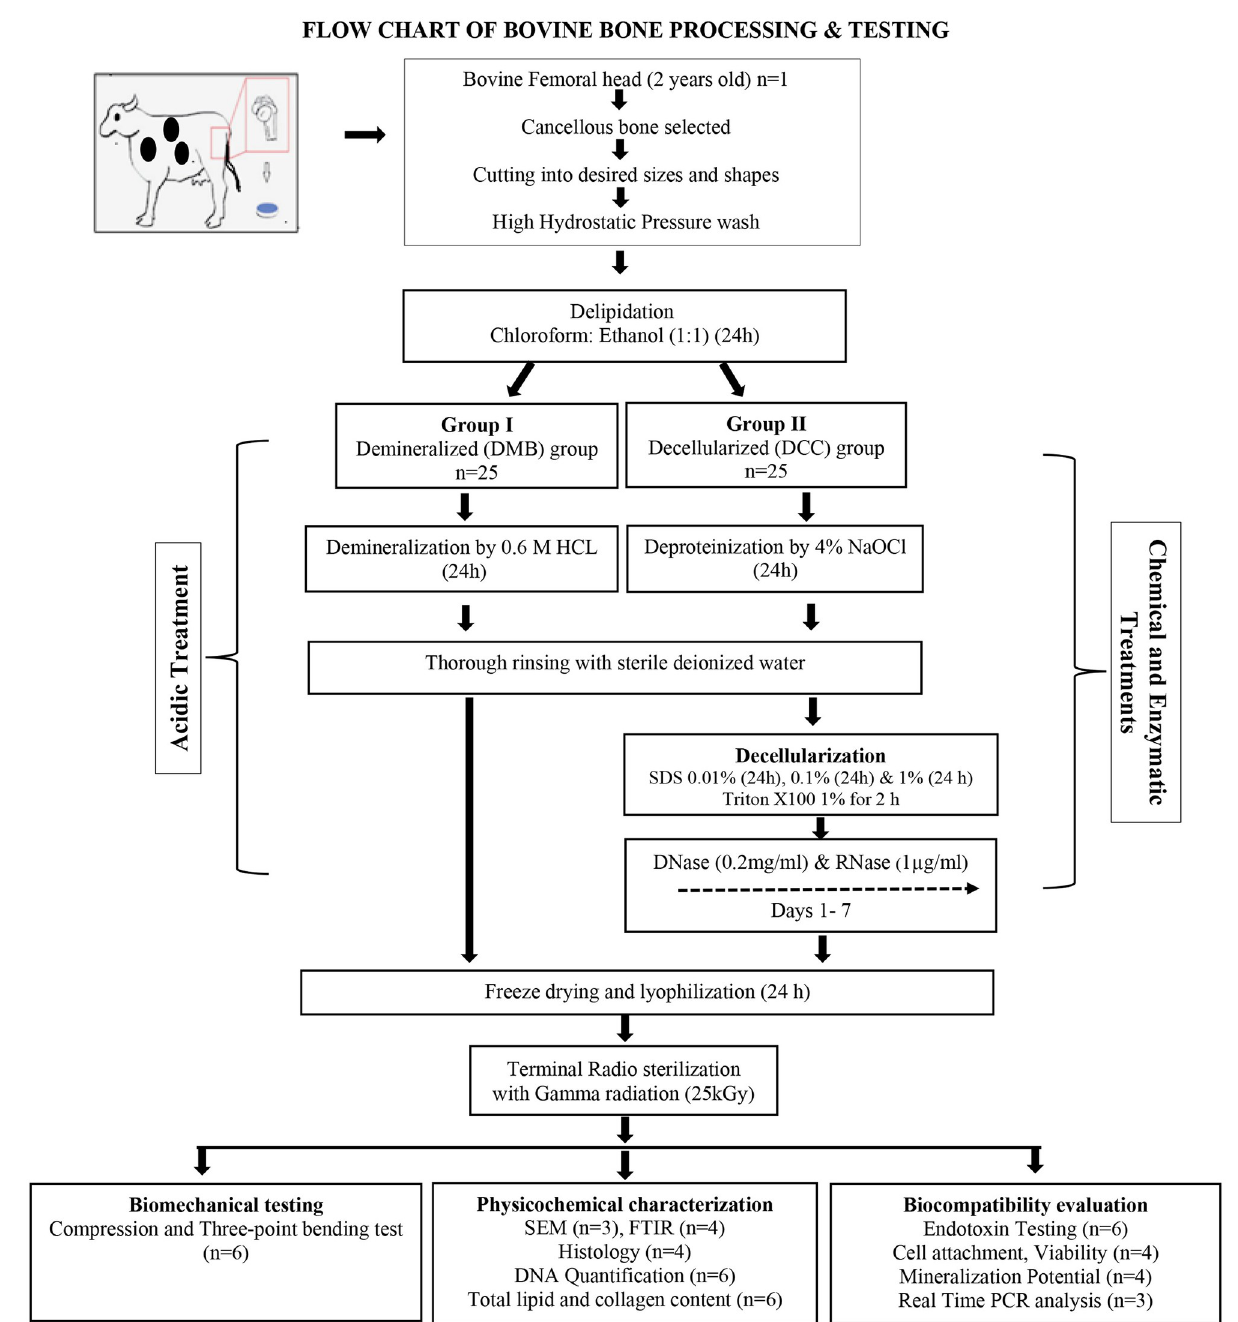
Fig 1. Bone processing steps. Schematic diagram depicting the sequential processing steps of producing lyophilized scaffolds of demineralized bovine cancellous bone (DMB) and decellularized bovine cancellous bone (DCC).